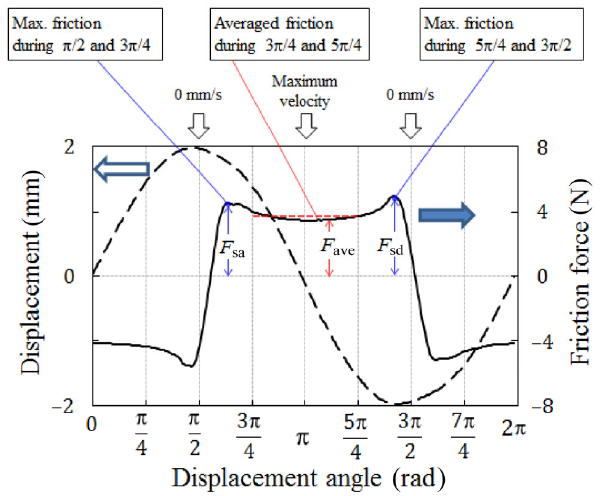
Fig. 4 Calculation concept of the spike index